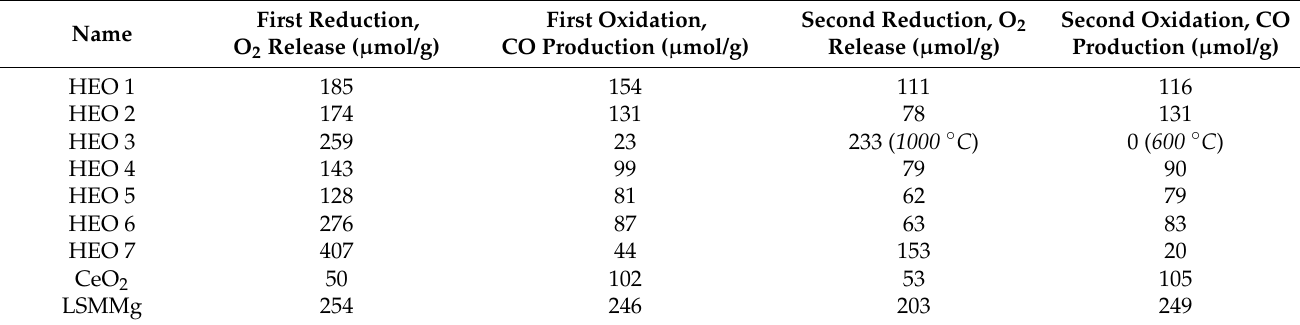
Table 1. Summary of O 2 release and CO production yields during two consecutive thermochemical cycles with the considered high entropy